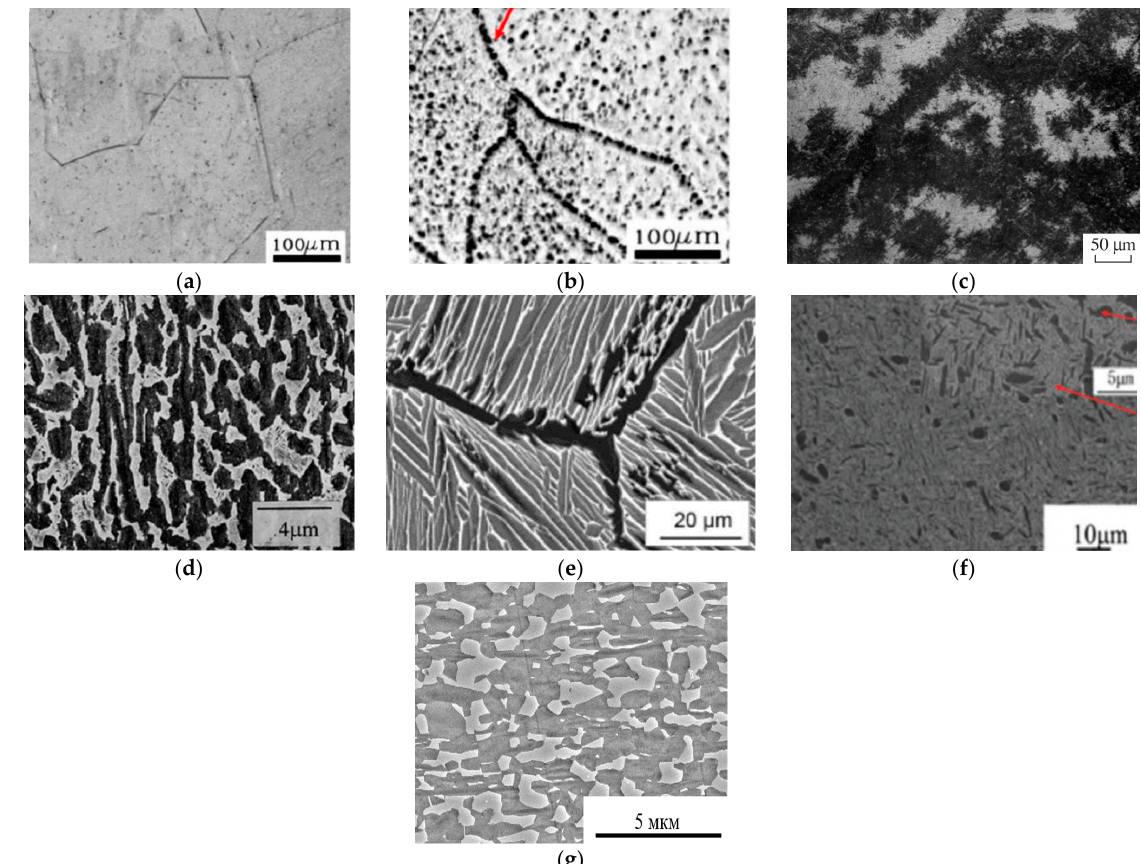
Figure 4. Typical microstructures of O-phase alloys: ( a ) Single-phase β (B2) with granular β (B2)- structure obtained by holding above β tr at 1100 ° С for 30 min and water quenching of Ti-22Al-25Nb O-phase alloy [30]; ( b ) two-phase β (B2) + α 2 state with α 2- precipitates at the boundaries and within β (B2) grains after quenching of Ti-22Al-25Nb alloy from ( β (B2) + α 2 )-region at 1020 ° С from [30]; ( c ) two-phase β (B2) + O state with lamellar structure of conglomerates of thin O-phase plates on the boundaries and within β (B2) grains after quenching of cast alloy VTI-4 from ( β (B2) + О )-region at 700 °C [31]; ( d ) two-phase β (B2) + O state with the structure of light deformed O-phase platelets in the dark β (B2)-matrix, obtained by hot deformation of Ti-22Al-27Nb alloy at temperatures below β tr [32]; ( e ) three phase β (B2) + α 2 + О state with lamellar structure with thick grain boundary α 2- plates and coarse secondary O-phase plates on the boundaries and within β (B2) grains after slow cooling from heating temperatures above β tr of Ti-22Al-25Nb [4]; ( f ) three-phase bimodal structure of equi- axed dark primary α 2 -precipitates (indicated by upper arrow) and packets of thin O-phase lamellae (indicated by lower arrow) in β (B2)-matrix obtained in the Ti-22Al-25Nb by forging at 1020 ° С fol- lowed by solid solution treatment at 960 ° С and aging at 780 ° С [30]; ( g ) two-phase β (B2) + O state with equiaxed O-phase structure in β (B2)-matrix obtained in the Ti-23Al-27Nb by quenching from 900 ° С after hot rolling in ( β (B2) + О )-region. Reproduced with permissions from John Wiley and Sons [4], Elsevier [27,29] and Springer [31].